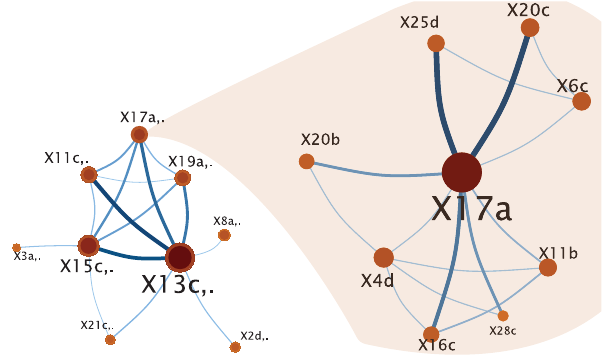
FIG. 6. Result of InfoMap partitioning of the backbone response network. (Left) InfoMap finds 9 different modules, each of which are connected to each other. (Right) Each module also has internal structure, here shown for the module labeled “ X17a.